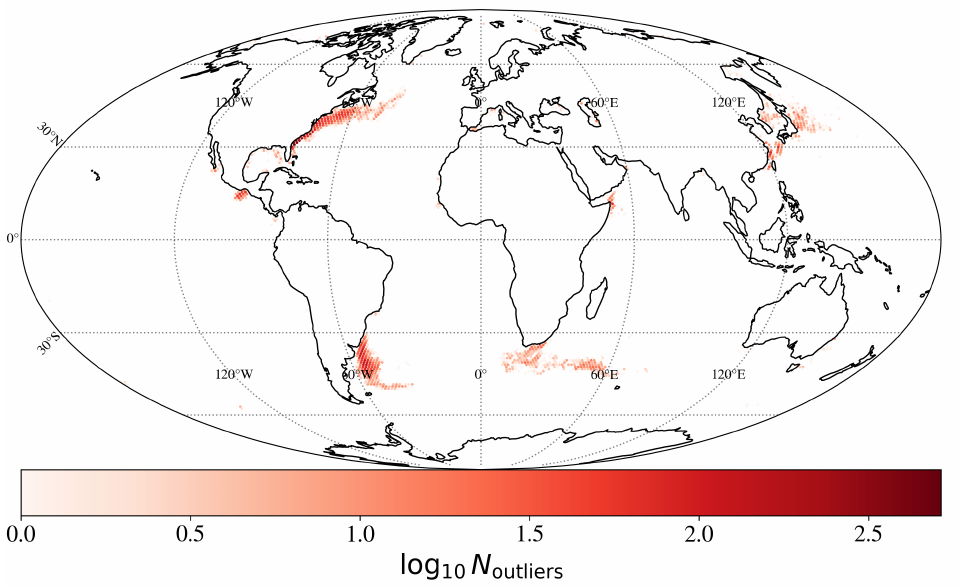
Figure 6. Depiction of the spatial distribution of the outliers discovered by ULMO . These are primarily in the well-known western boundary currents off Japan, North and South America and South Africa. Note that the scaling is